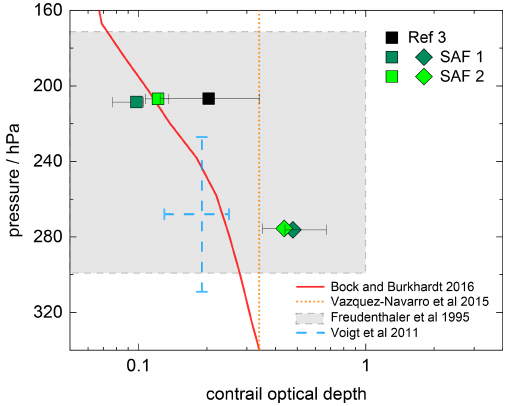
Figure 5. Individual contrail optical depths (CODs) determined from observations and models. Concerning the ECLIF II/NDMAX data, the fuels are distinguished by colour and the altitudes by sym- bol. Bars show the COD range for the uncertainty of the physical depths of the